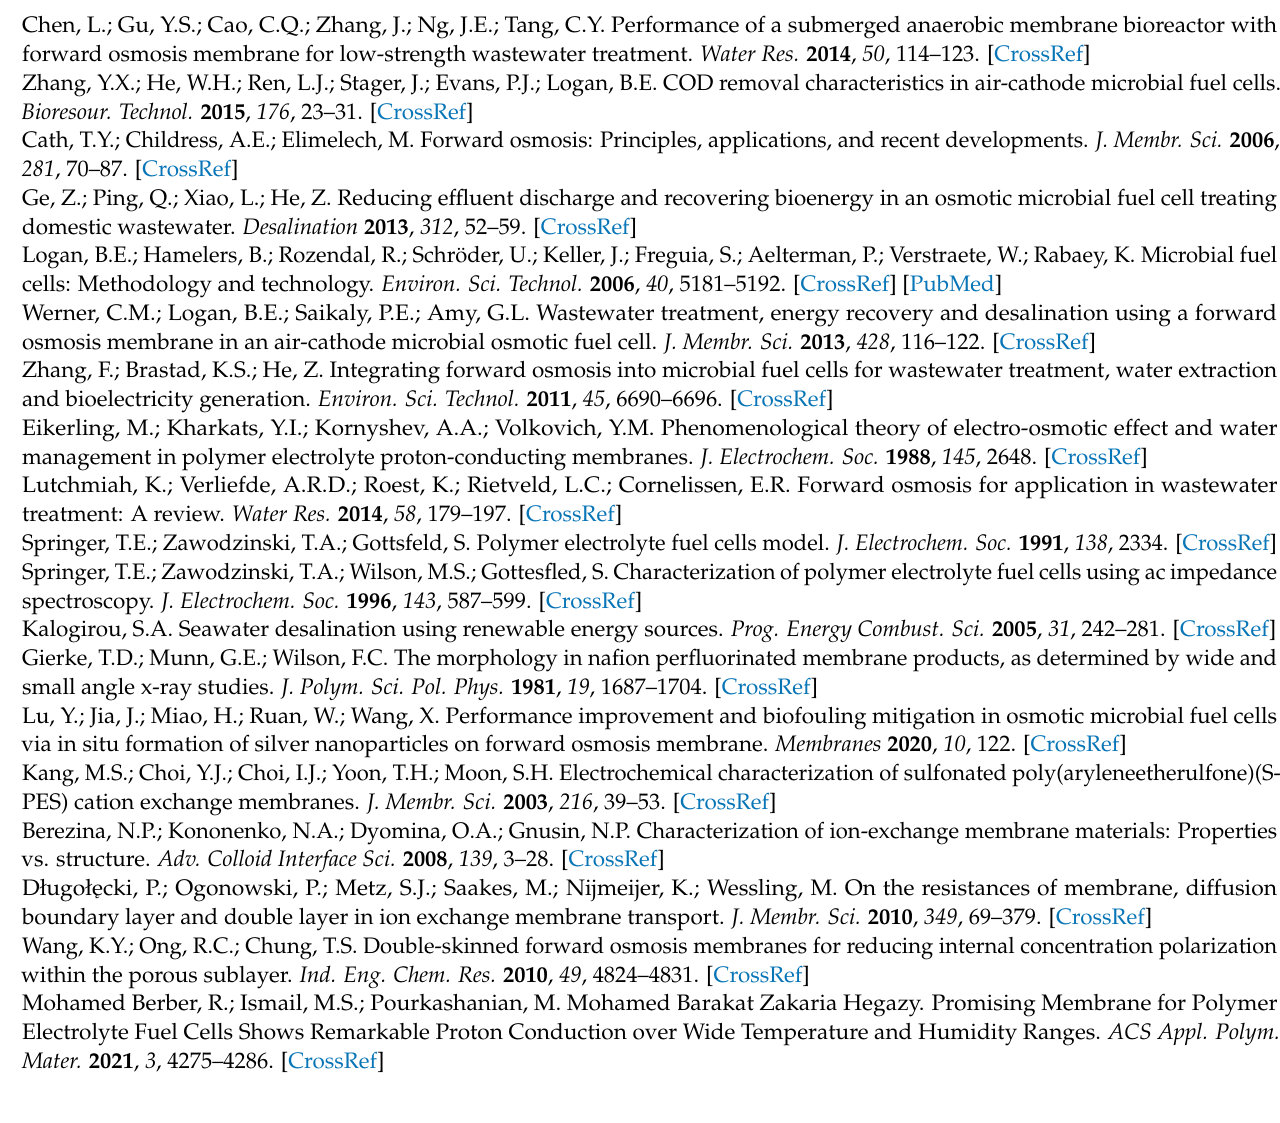
Figure S2: Set-up for measurement of the water transport number t H2O , Figure S3 Similar current generation under different conditions (1 M NaCl as catholyte/117.6 Ω external resistance initially and 2.5 M NaCl as catholyte/2358 Ω external resistance